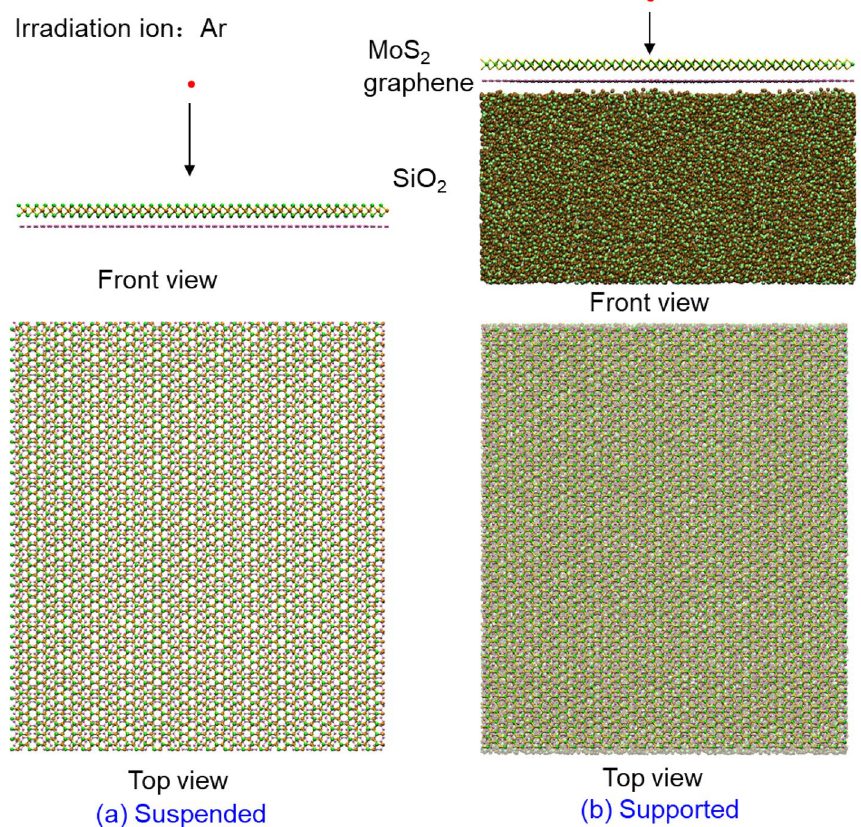
Figure 1. Schematic of the simulation model for ( a ) suspended and ( b ) supported